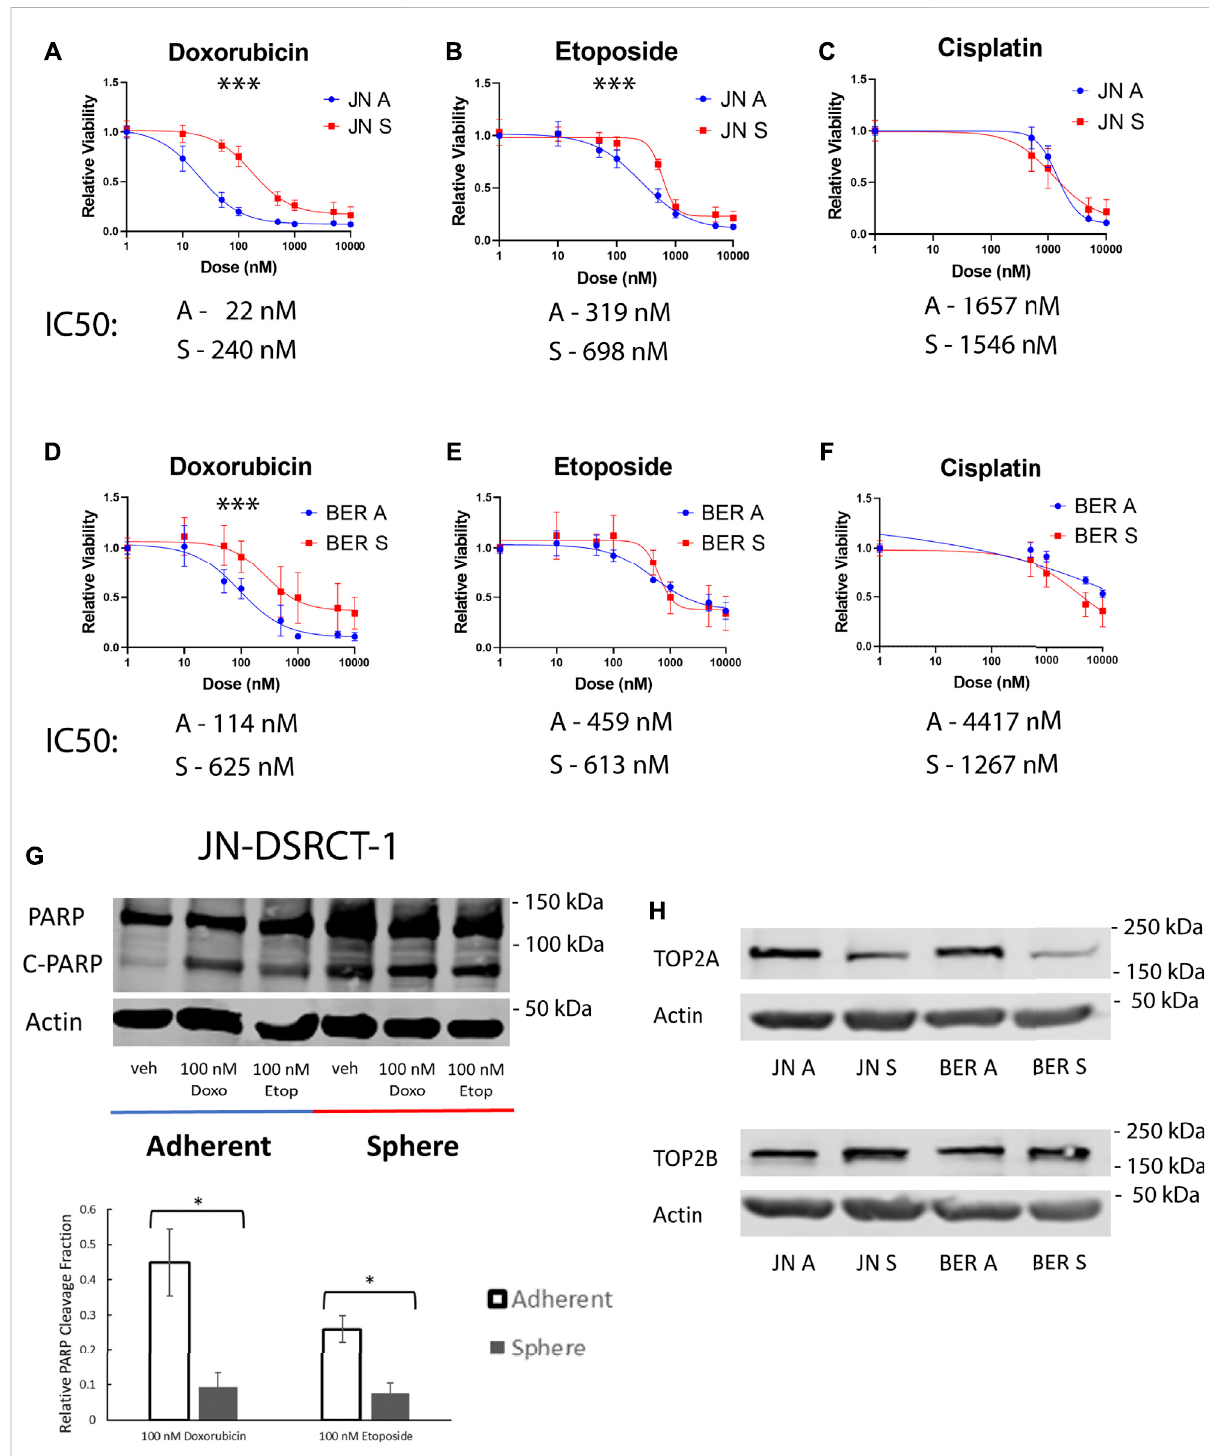
DSRCT CSC-like cells are resistant to chemotherapy. (A – C) Relative viability of JN-DSRCT-1 cells grown in adherent or sphere culture and treated with doxorubicin (A) , etoposide (B) or cisplatin (C) for 72-h. (D – F) Relative viability of BER-DSRCT cells grown in adherent or sphere culture and treated with doxorubicin (D) , etoposide (E) or cisplatin (F) for 72-h(*** p < 0.001, ANOVA). (G) Western blot of PARP and cleaved PARP after 24 h treatmentwithvehicle,100 nMdoxorubicin,or100 nMetoposideinadherentorspherecultureconditionsinJN-DSRCT-1( n =3,* p < 0.05). (H) Western blots of TOP2A and TOP2B protein expression in JN-DSRCT-1 and BER-DSRCT cells grow in adherent (A) or sphere (S)